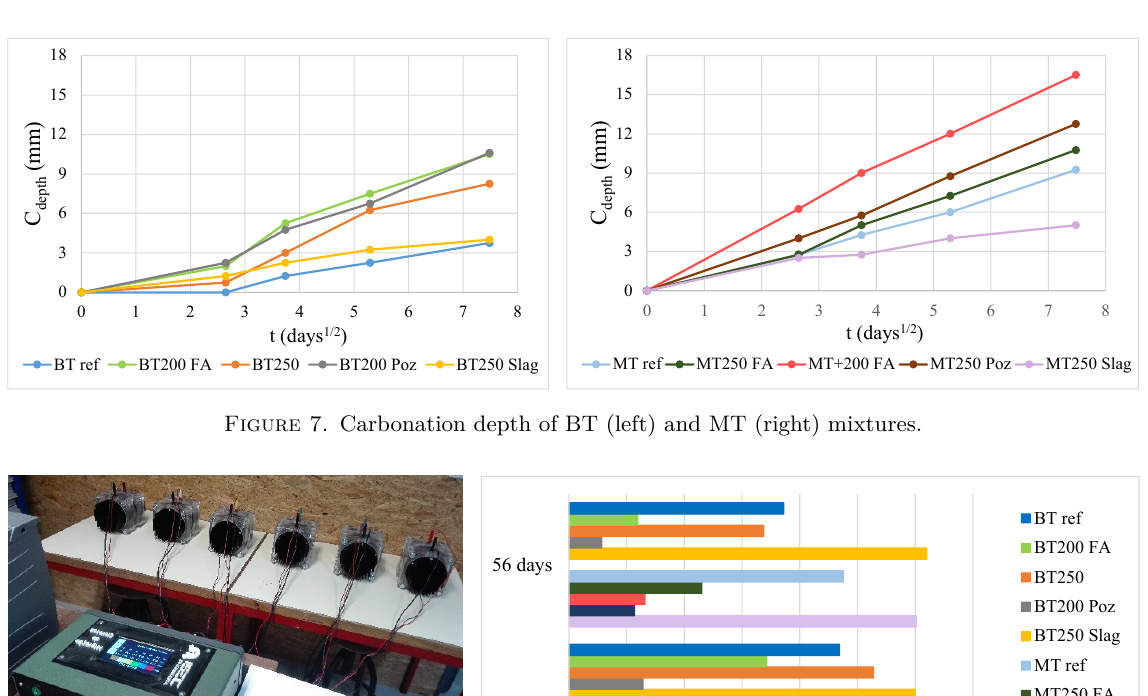
Figure 6. Chamber for the carbonation test and evolution of carbonation MT250FA with time.